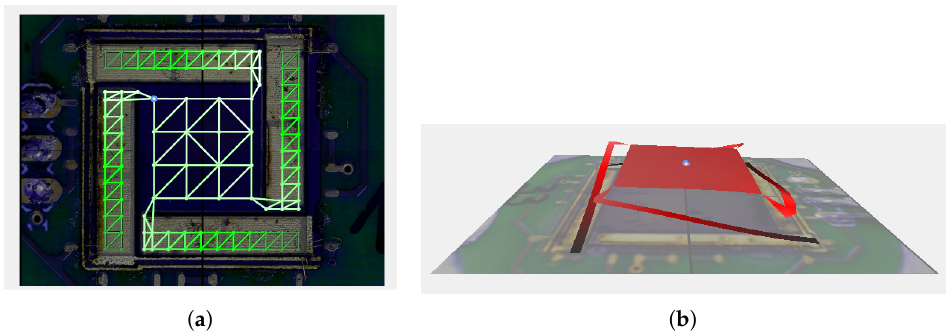
Figure 18. ( a ) Scanning points use for vibration measurements. ( b ) Displacement profile reconstruc- tion of the Type 3 device at 400Hz.